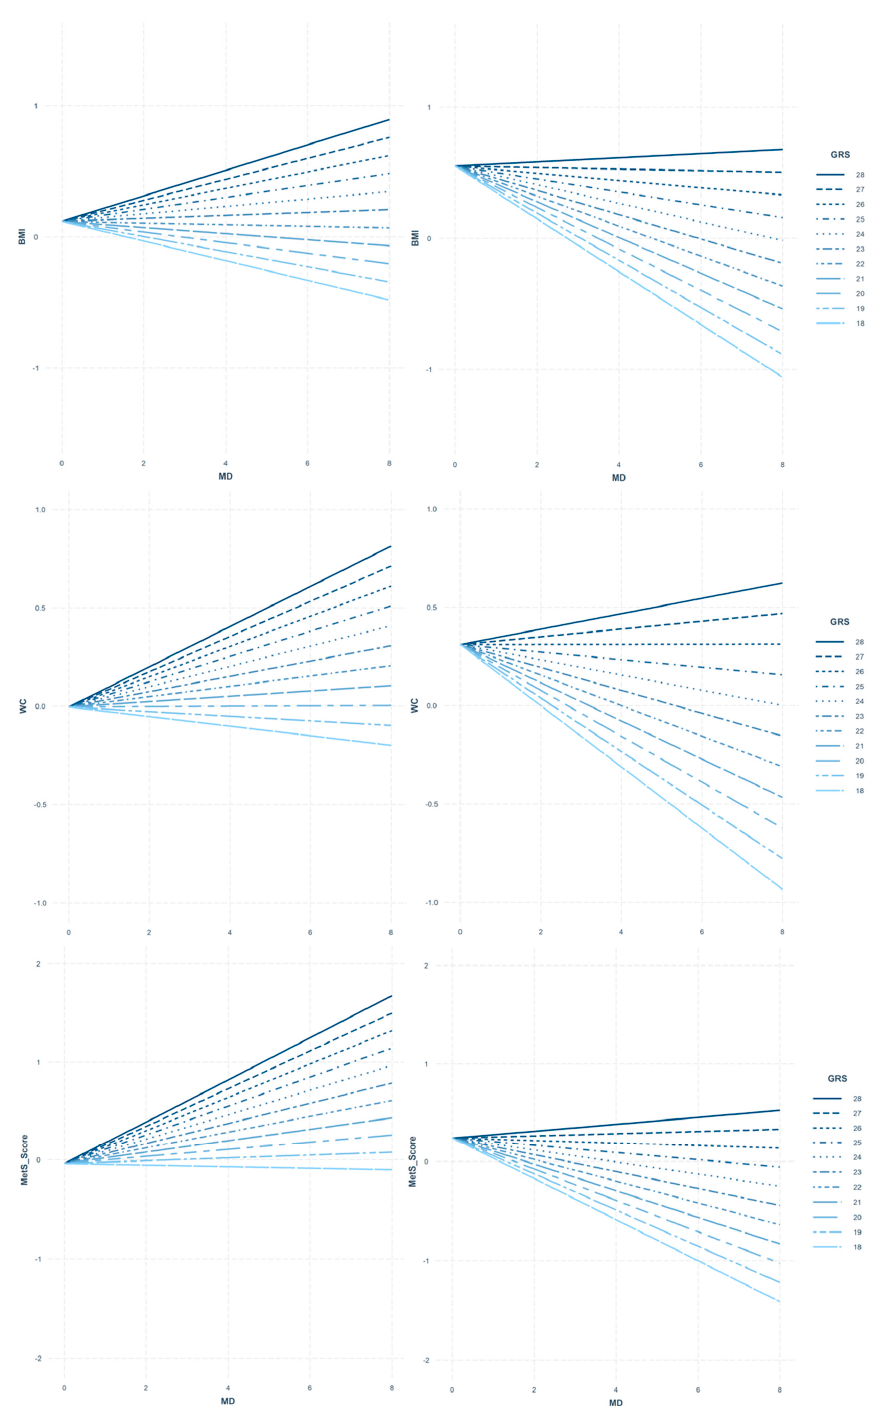
Figure 3. Matrix panel of interaction models between body mass index (BMI), waist circumference (WC), and metabolic syndrome score (MetS Score); and the Mediterranean diet (MD) according to the obesity genetic risk score (Obesity-GRS) modulation compared by sex (males left panel, females right panel). Obesity-GRS values (18–28) displayed according to our population distribution. Legend: when designing the population distribution representation, di ff erent lines were drawn as reference points to observe the trend of the studied population according to the genetic predisposition to obesity. When analyzing the results represented in these figures, a positive gradient shows the MD acting as risk factor, whereas a negative gradient indicates the protective role of the